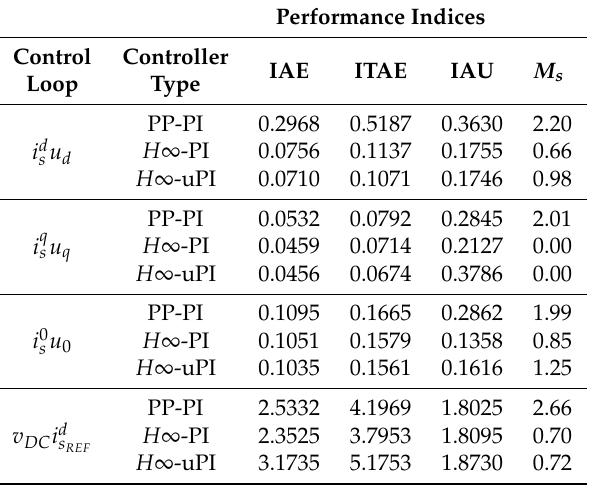
Table 3. Summary of the PI controller dynamical performance